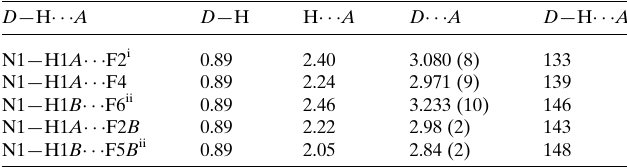
Table 1 Hydrogen-bond geometry (A˚ , (cid:5) ).